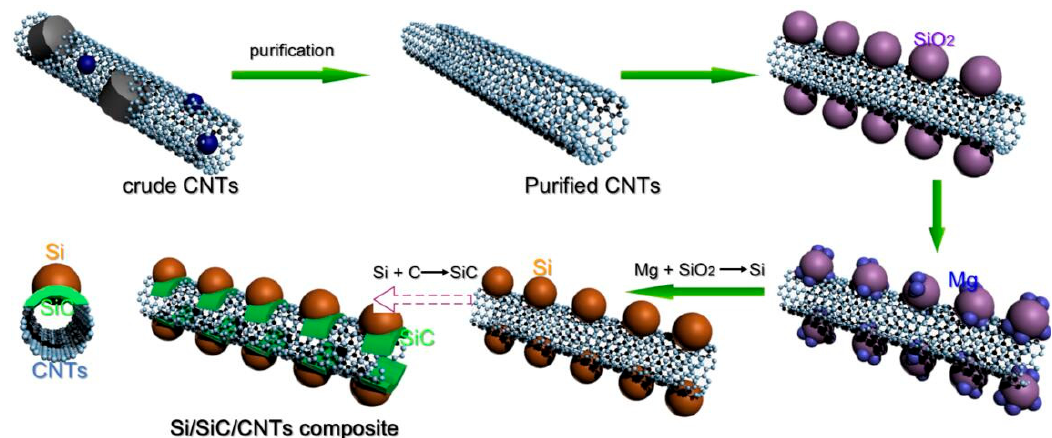
/ SiC / carbon nanotubes’ (CNTs) nanocomposite Figure 1. The schematic illustration of Si/SiC/carbon nanotubes’ (CNTs) nanocomposite preparation. Figure 1. The schematic illustration of Si